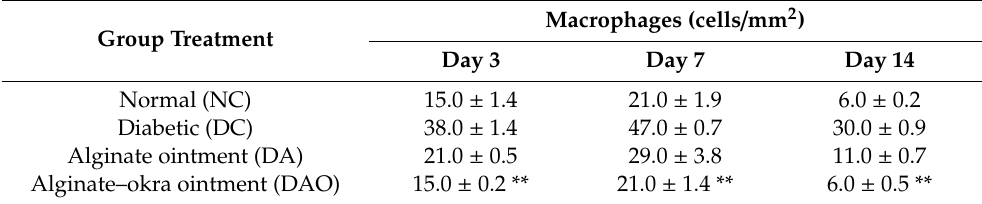
Table 5. Counts considering the mean and standard deviation of